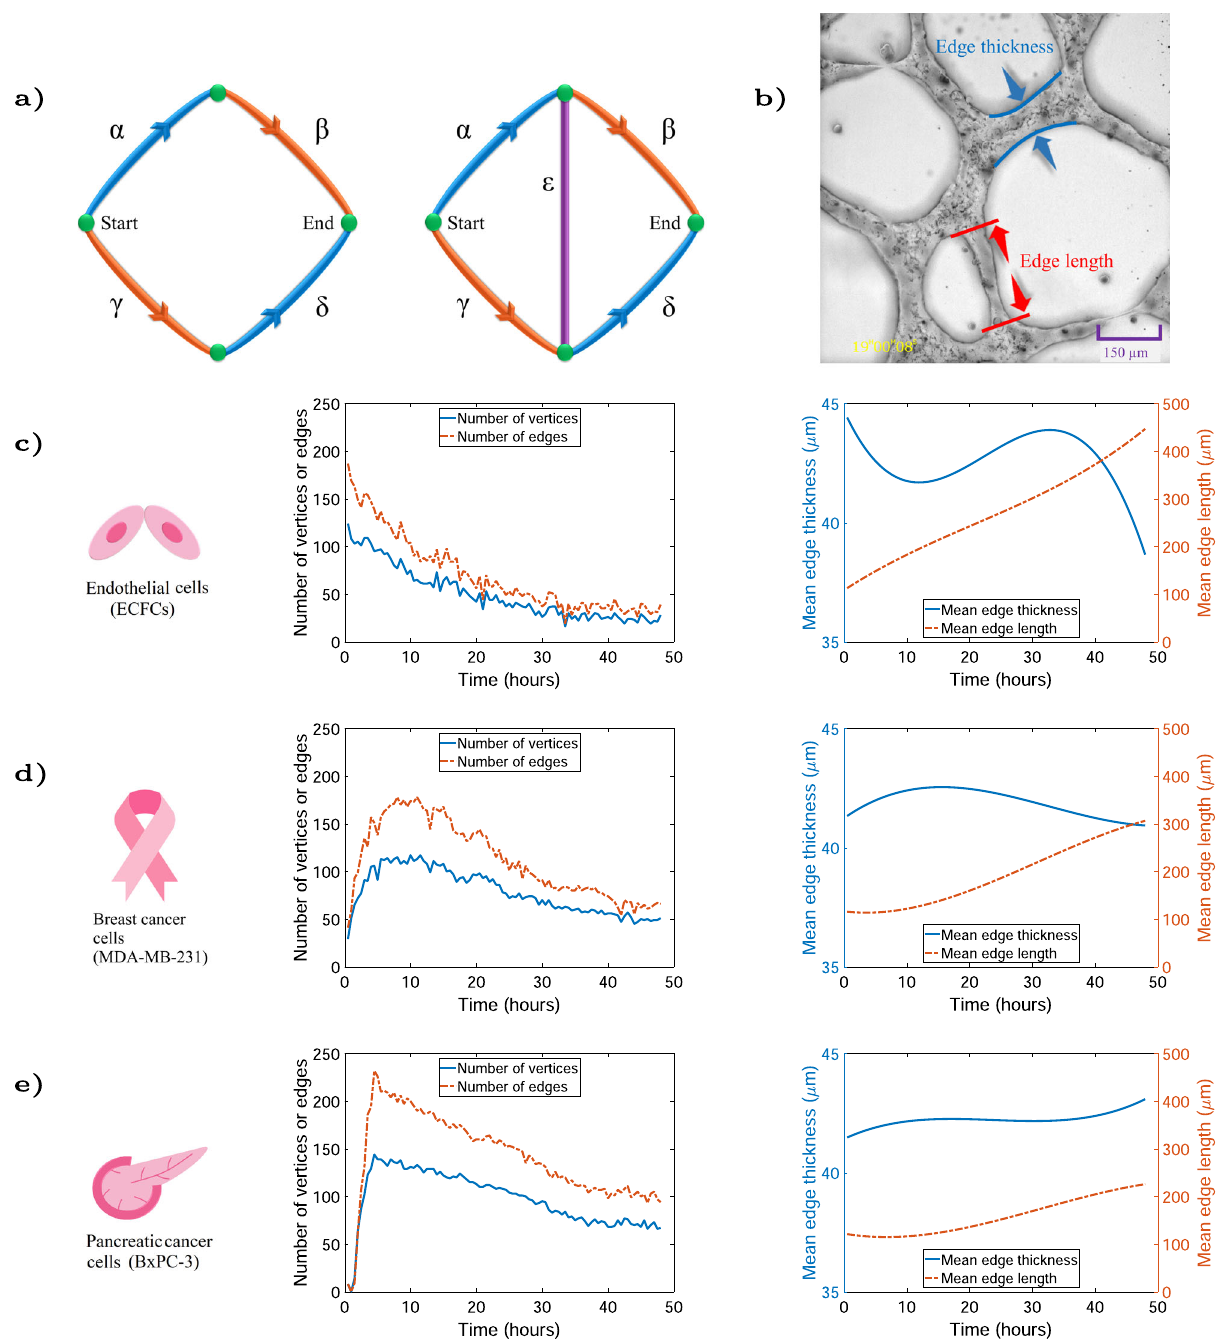
Fig. 4 Braess paradox in vascular networks. a A traf fi c network example is demonstrated to explain Braess paradox where a simple network consisting of two routes connecting the start and end points. The travel time along orange roads is given by ρ /100 min, where ρ represents the number of vehicles, while the traf fi c time is 45 min for the blue roads. In equilibrium, traf fi c will distribute evenly between these two routes connecting start to end. Therefore, the travel time for total 4000 vehicles (2000 for each path) is 65 min (45 min for blue and 20 min for orange roads) along each of the two routes. Installation of the purple road with an extremely short travel time of approximately zero minutes on the bottom map offers the third route ( γεβ ). Drivers begin to use the new route, reducing the travel time from 65 to 40; however, as more vehicles choose the new route, the travel time will increase to 80. b The edge thickness and length are de fi ned here. c The average number of edges and vertices is shown in red and blue lines (left panel), and the mean edge thickness and length are shown in blue and orange lines (right panel) for fi ve EC networks. It may be seen that the mean edge length trend increases signi fi cantly for ECs. d The graph in part c is plotted for fi ve breast cancer cases. e The formation graph in parts ( c ) and ( d ) is plotted for fi ve pancreatic networks. A similar trend can be seen in the rate of mean edge length and thickness in both cancers in part ( d ) and ( e